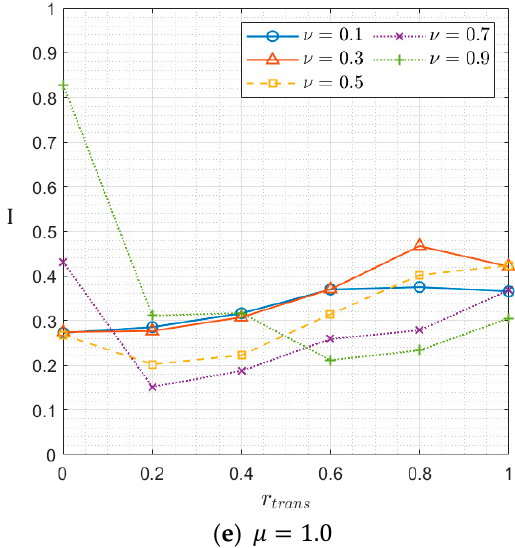
( e ) 𝜇 = 1.0 Figure 5. The effect of the transition time ( r trans ) and fixed vortex centre ( ν ) on mixing performance ( I ) with fixed iterations of 10, which indicates that ( a ) total time is 0.5; ( b ) 1.25; ( c ) 2.5; ( d ) 5; and ( e ) 10 with different periods ( 𝜇 ).